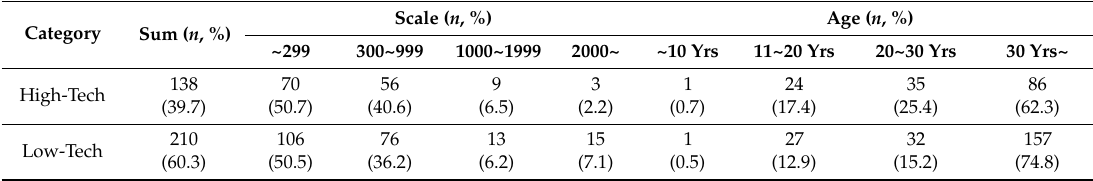
Table 4. General characteristics of firms ( n = 348).